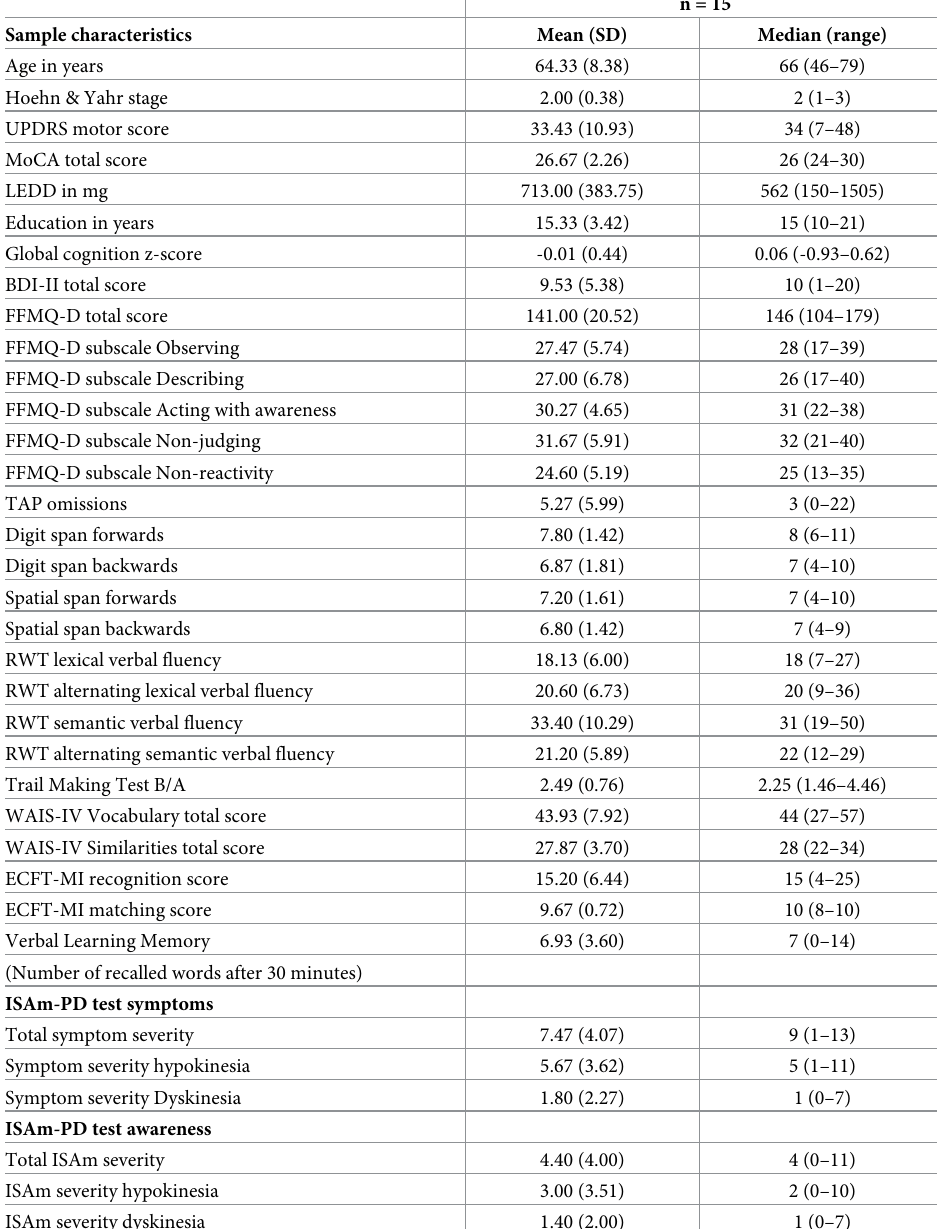
Table 3. Sample characteristics of fMRI